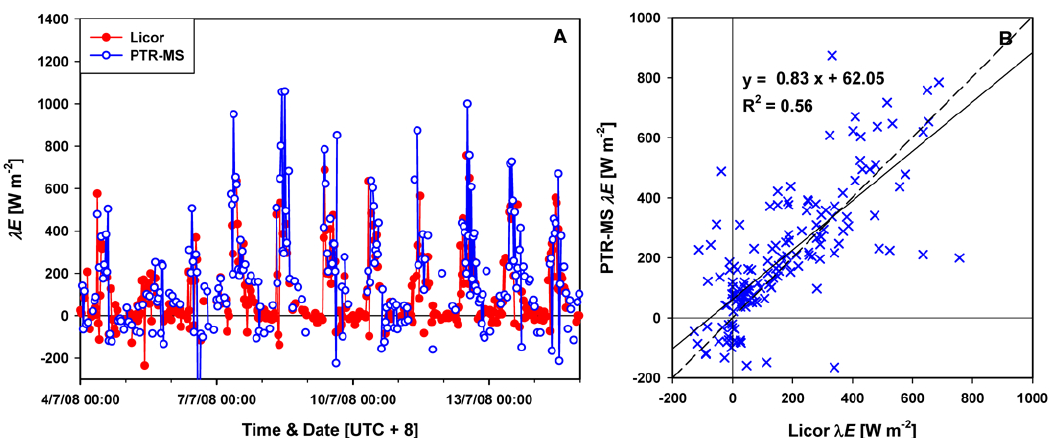
Fig. 2. (A) Latent heat fluxes measured at the GAW site during the period of 4–14 July by open path IRGA (LICOR – 7500) and PTR-MS. PTR-MS water vapour measurements recorded as m/z 37 were calibrated against a closed path IRGA (LICOR – 7000) which sampled from the same 70m sample line as the PTR-MS. (B) indicates the amount of flux lost due to attenuation along the long sample inlet and can be used to estimate a worst case scenario of VOC flux